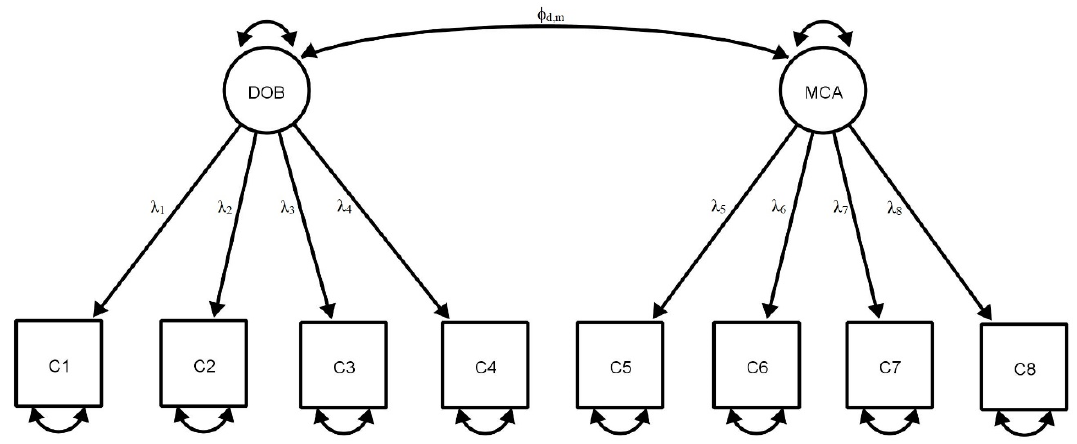
Figure 1. Final standardised model of the 8-item Cybercrime Rapid Identification Tool; DOB = deviant online behaviour; MCA = moral, control and aggression.